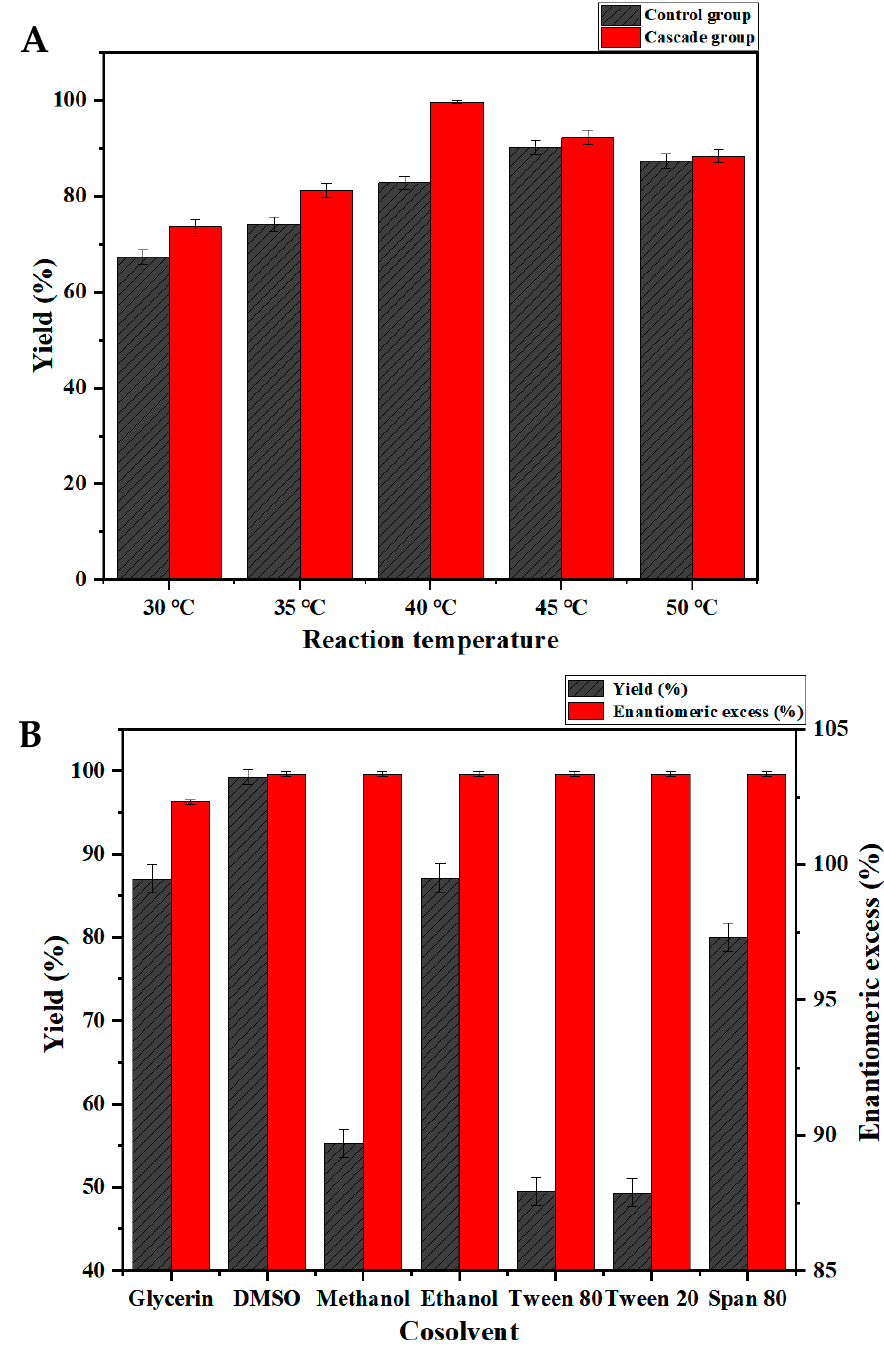
Figure 4. Effects of reaction temperature ( A ) and cosolvents ( B ) on the cascade reaction with free ATA117 and ADH expressed by single expression system.